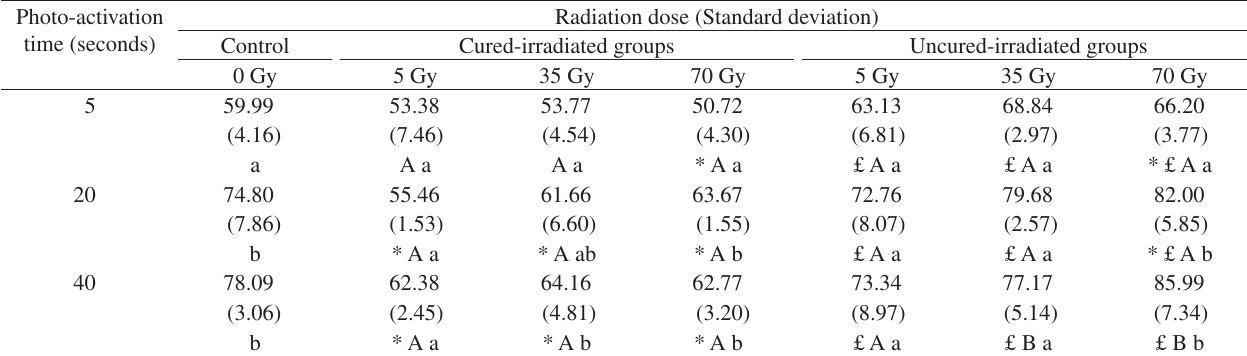
Radiation dose (Standard